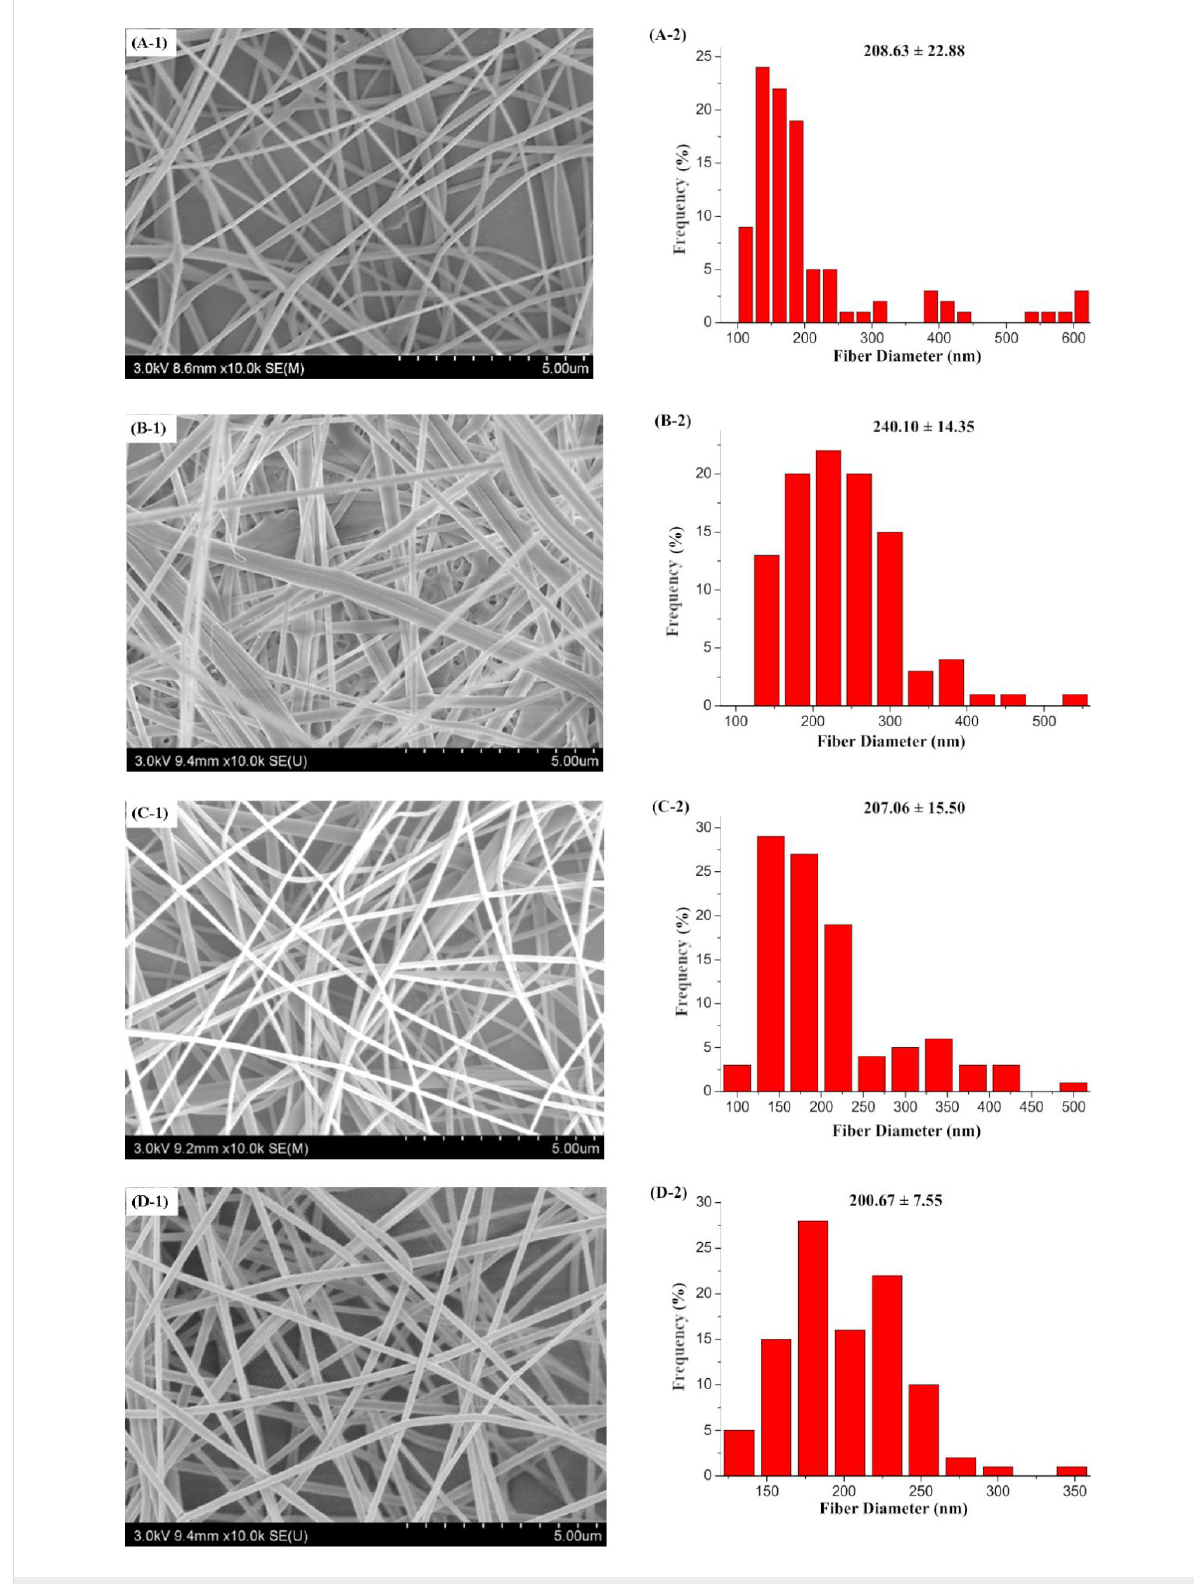
Figure 11: SEM images and the corresponding diameter distribution of the PAN nanofibers obtained by the four self-made FSE devices. A, B, C, and D correspond to MBE, MFSE, OSFSE and